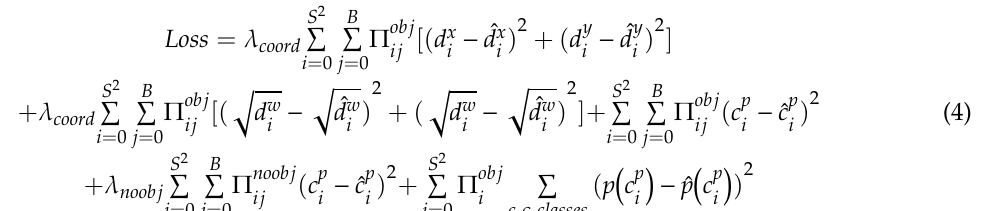
Figure 3. Simplified layer architecture of You Only Look Once (YOLO)v3 network.